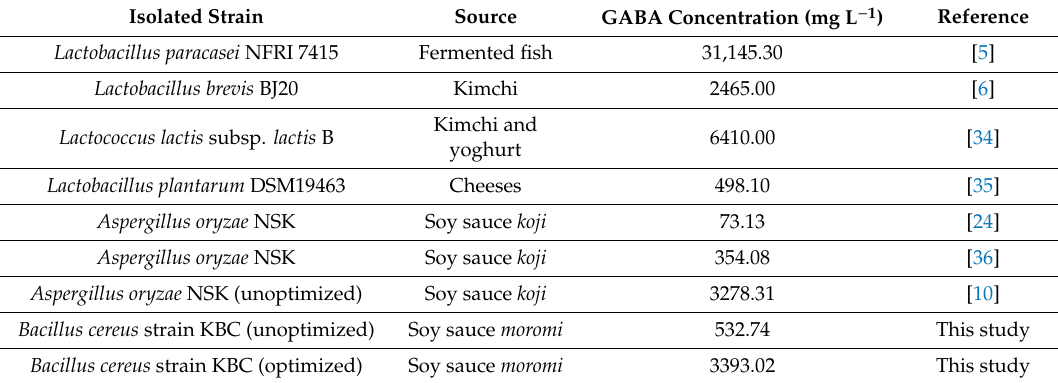
Table 4. GABA concentration by microorganisms isolated from various food sources.